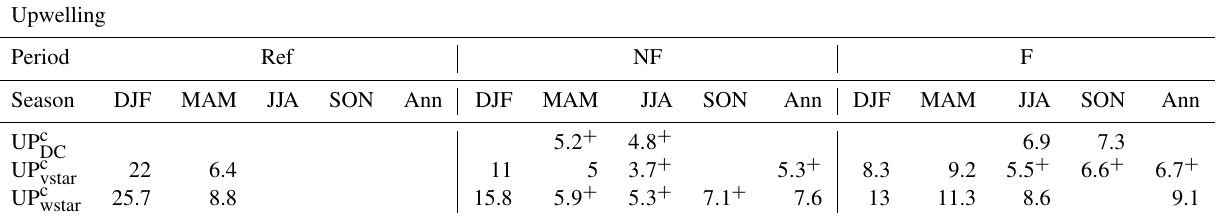
Table A2. Trends of UP (in 10 7 kgs − 1 per decade) computed with three different methods after the correction for the vertical shift of pressure levels (UP c wstar , UP c vstar and UP c ) in the Ref, NF and F period. Presented are trend values significant at least at the 90% confidence level DC or at least at the 80% confidence level (denoted by superscript + ); otherwise, the cell is left blank.